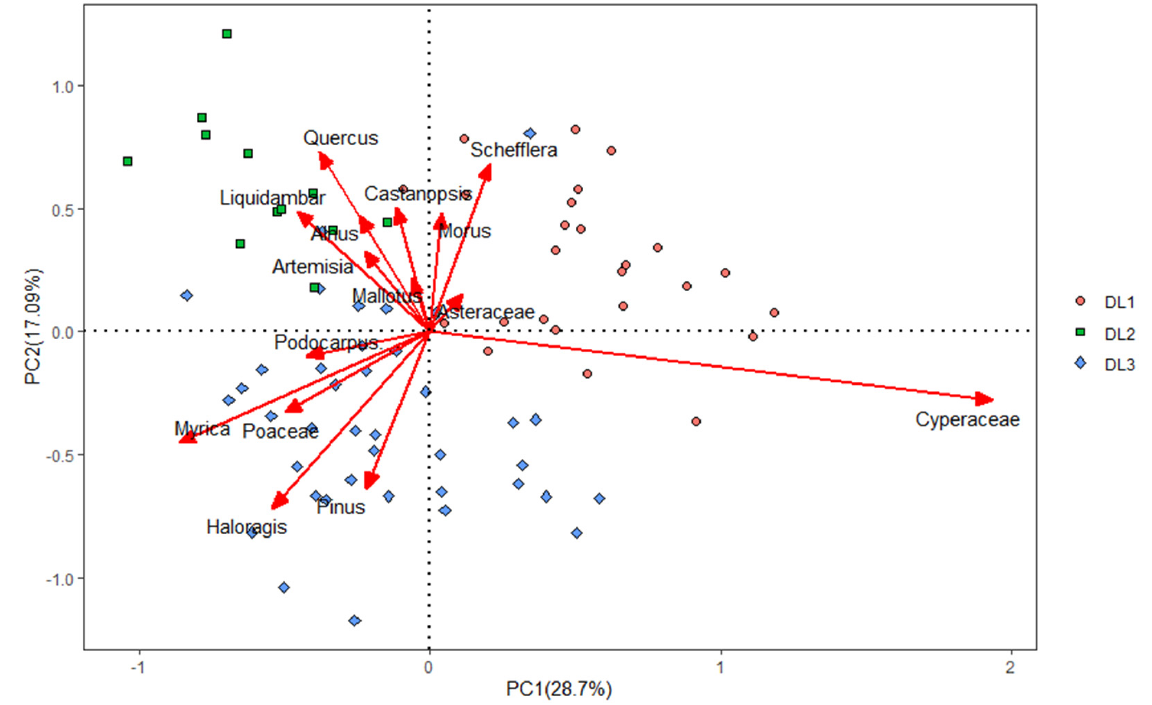
Figure 7. Principal component analysis biplot of the pollen composition of sediments from Dream Lake. The samples in DL4 were considered to represent modern deposition and were removed from the ordination analysis.